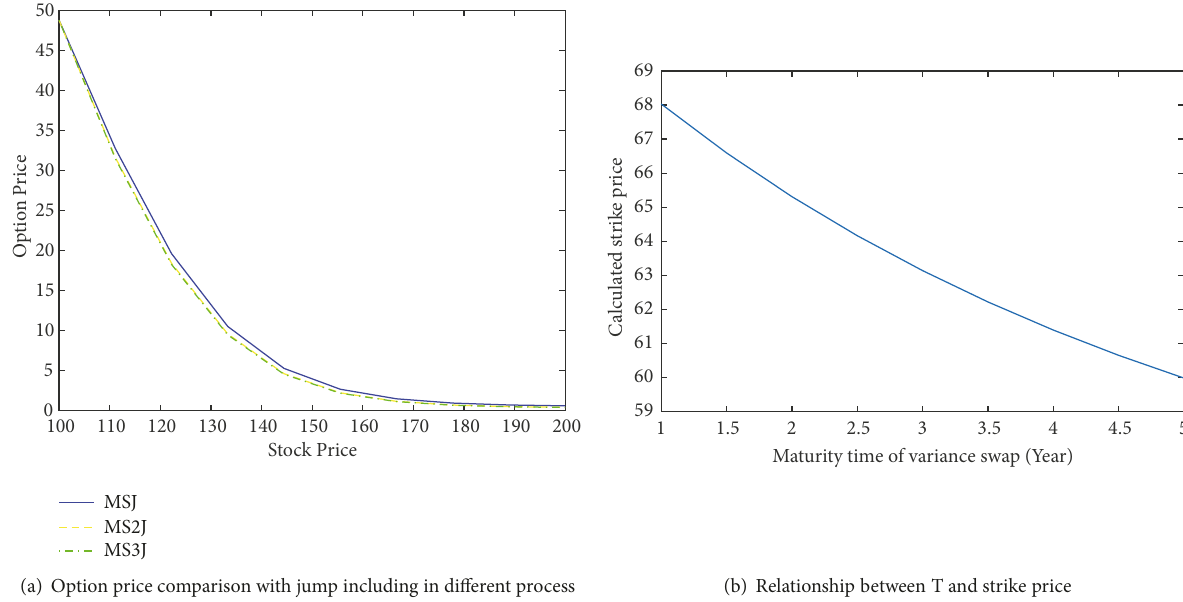
Figure 8: The effect of jump intensity rate 𝜆